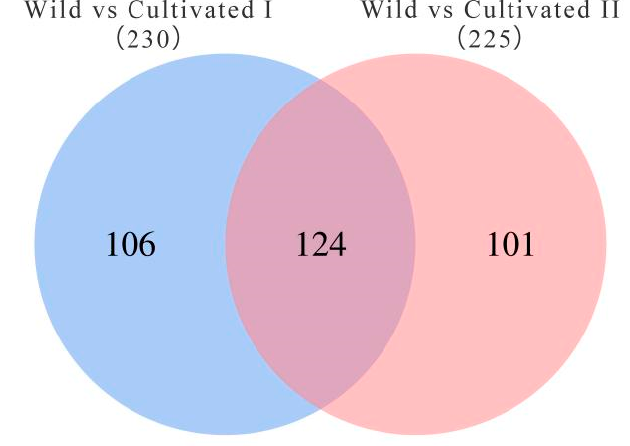
Figure 7. Venn diagram of the number of metabolites with significant differences between the different sources of YCH.